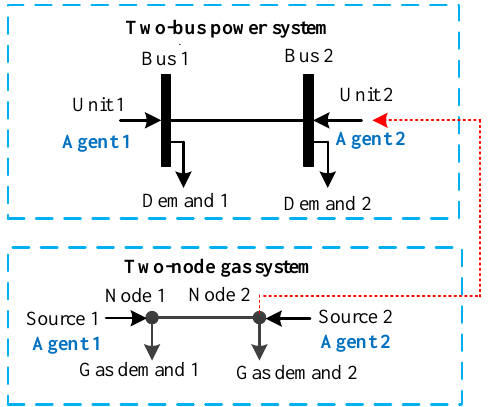
Figure 1. Example: two-bus power system and two-node gas